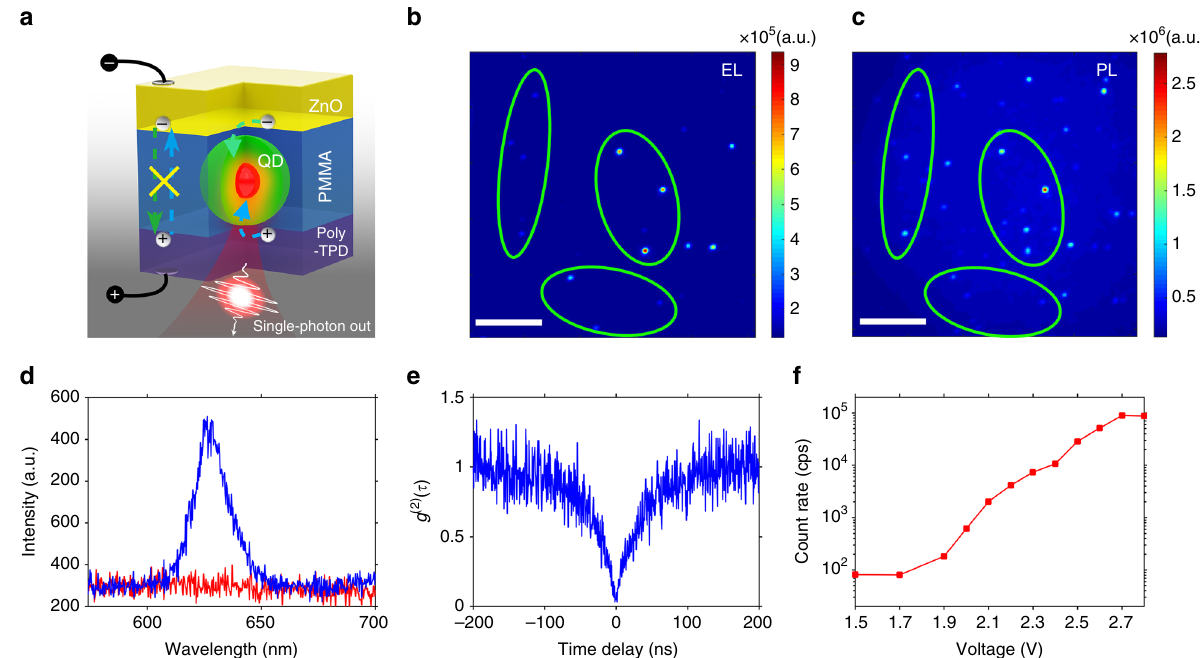
Fig. 1 Optical properties of a single-photon device. a Schematic diagram of the key components of the device. b , Electroluminescence (driven at 2.4 V) and c , the corresponding photoluminescence (excited by 450 nm continuous wave laser) microscopic images. Scale bar: 5 μ m. Green circles in b and c are shown as visual guides to highlight the relevant dots. d Electroluminescence spectrum (blue curve, driven at 2.8 V). The noise counts from the detector are also plotted (red curve). e g (2) ( τ ) curve of a quantum-dot driven at 2.6 V. f Averaged electroluminescence counts of a single dot under different driving voltages ( y -axis in